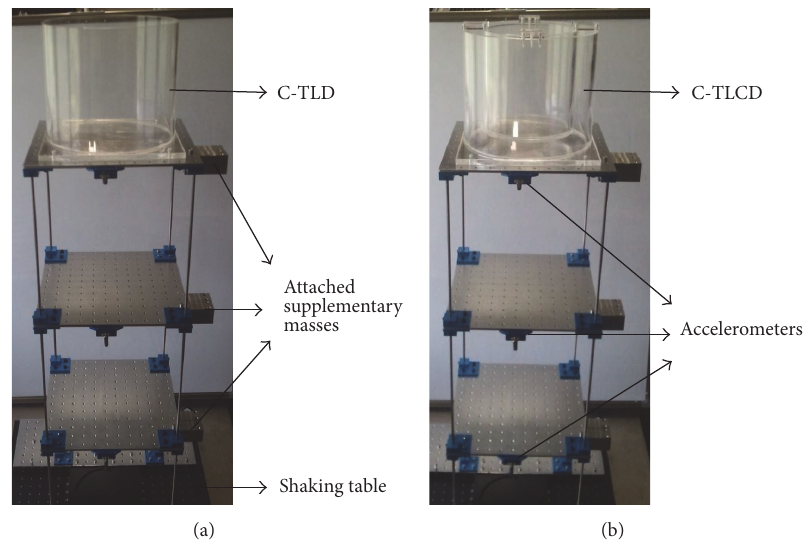
Figure 3: Experimental setup of the scaled model attached with the passive controllers on the top floor, supplementary mass, and accelerometers: (a) C-TLD and (b) C-TLCD.